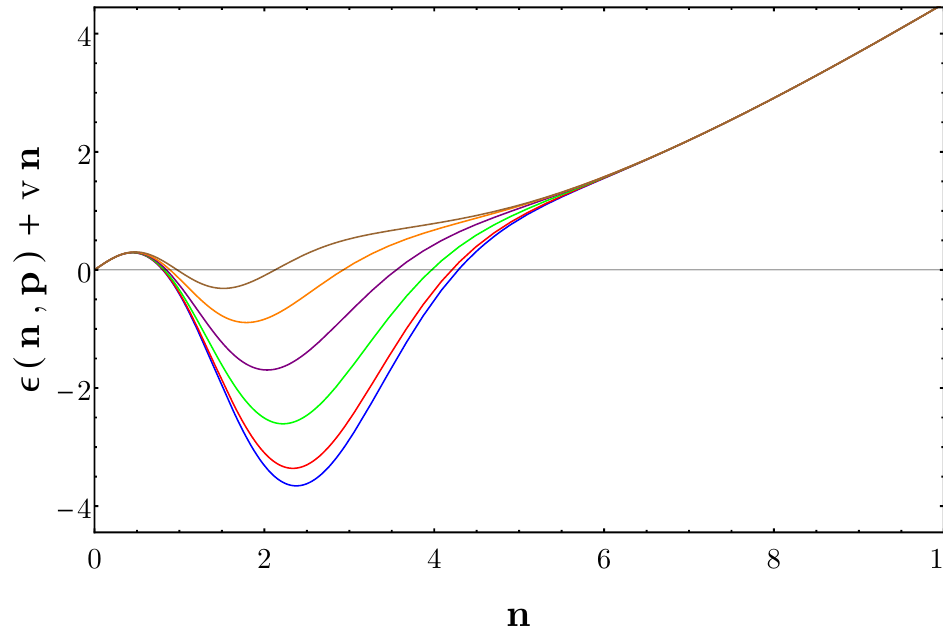
Figure 7 . Energy spectrum ε ( n , p ) + v n of ν = 1 large neutral excitations plotted as a function of n for values of p = 0 , 1 , . . . , 5 (from bottom to